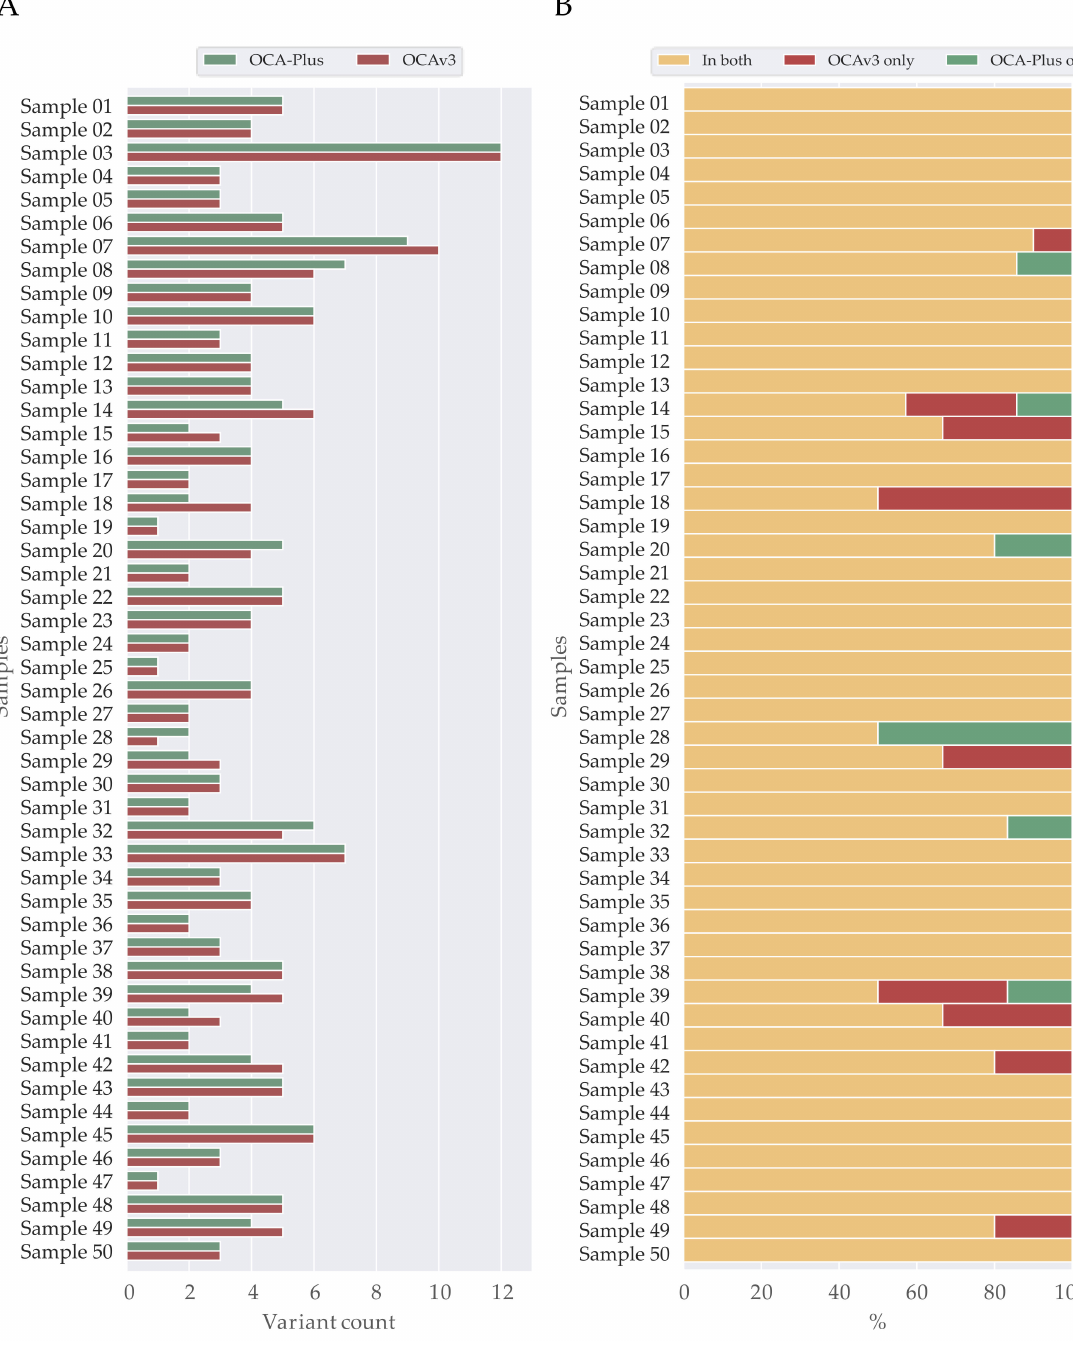
Figure 4. Counts and overlap of identified variants in OCAv3 and OCA-Plus. ( A ) Bar-chart showing locus variants count per samples. ( B ) Stacked bar-chart of percentual overlapping locus variants of OCAv3 and OCA-Plus per samples; 37/50 samples overlapped completely and 13/50 showed difference in locus variants, hence only identified in one of the